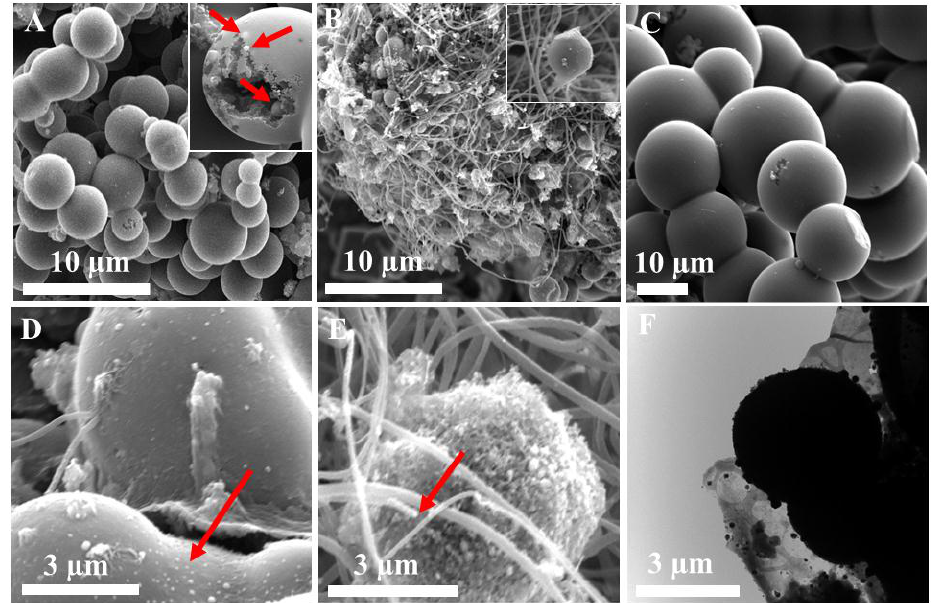
Figure 1. SEM images of ( A ) carbon microspheres formed from char material of hydrothermally treated apricot resin (HT-APG-Fe), ( B ) integrated structure composed of CMS and CFs of HT-APG-Fe pyrolysed with melamine at 950 °C (N-APG-Fe) (inset shows the presence of micro spheres and CFs), ( C ) carbon micro spheres of HT-APG-Fe pyrolysed without melamine at 950 °C (APG-Fe), ( D ) formation of CFs from FeMNPC from the sphere interior of N-APG-Fe (red arrow shows FeMNPC diffused out of the sphere after pyrolysis with melamine), ( E ) formation of CF from FeMNPC diffused out of the sphere in N-APG-Fe (red arrow shows the CF forming from the tip of FeMNPC), and ( F ) TEM image of FeMNPC diffused out of the sphere in N-APG-Fe.